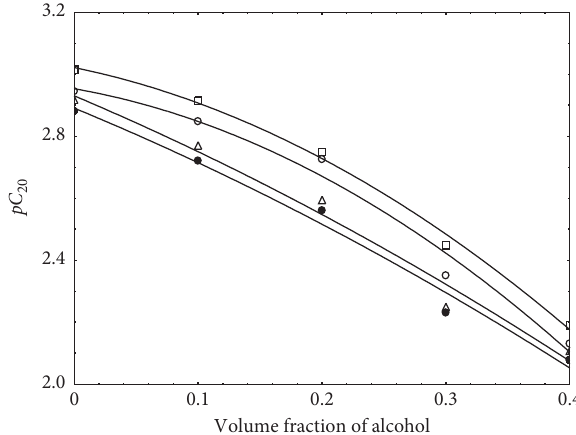
Figure 6: Variation in pC 20 CTAB with the volume fraction of methanol: squares (298.15K), circles (308.15K), triangles (318.15 K), and closed circles